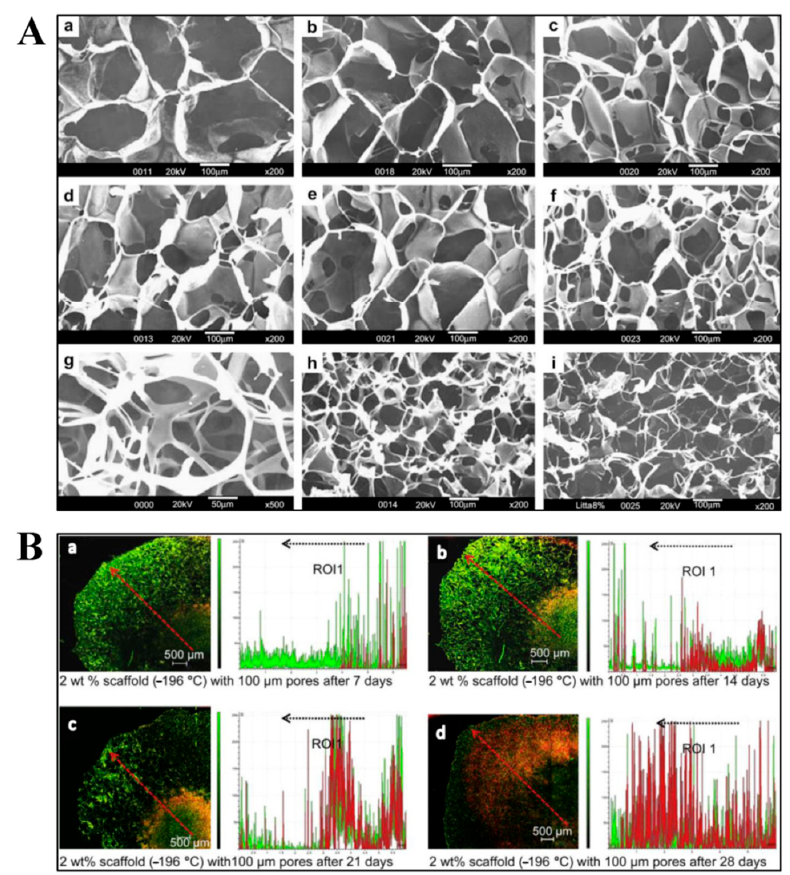
Figure 6. ( A ) Scanning electron microscope images of SF scaffolds fabricated by freeze-drying using ( a – c ) 2 wt % SF at − 20 ◦ C; ( d – f ) 4 wt % SF at − 80 ◦ C; and ( g – i ) 6 wt % SF at − 196 ◦ C; scale